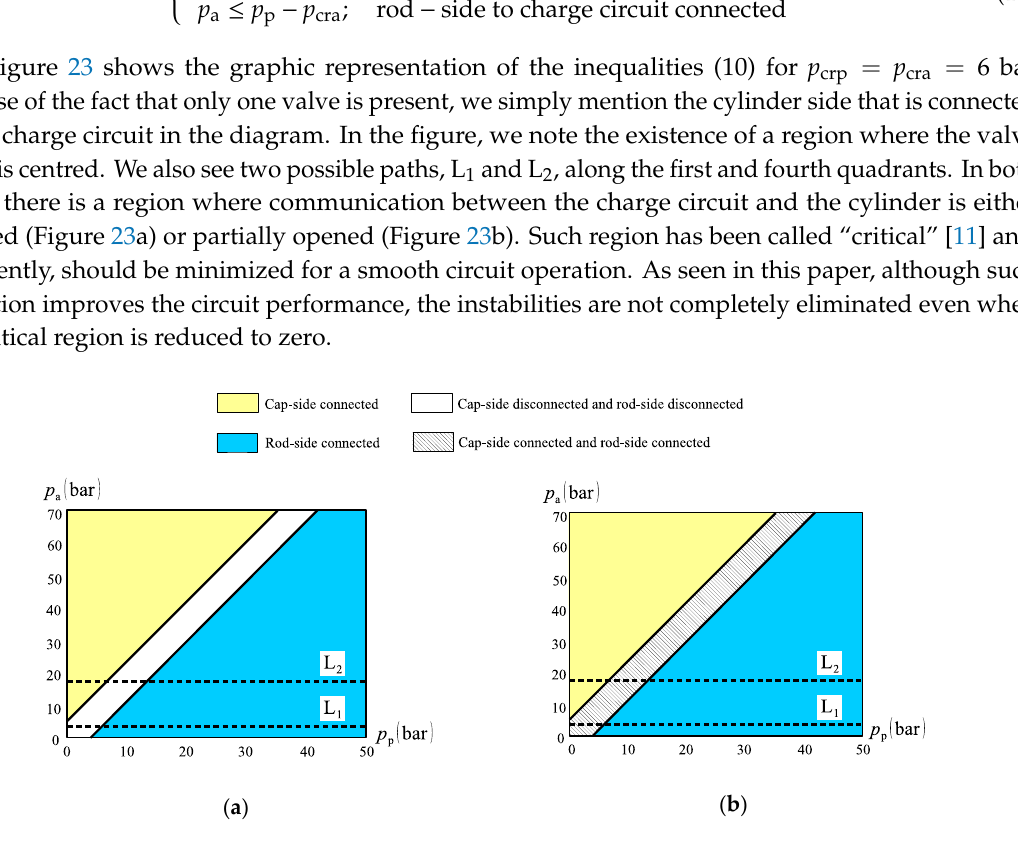
Figure 23. Connections between the cylinder sides and the charge circuit: ( a ) closed centred circuit (Figure 7a); ( b ) open centred circuit (Figure 7b).